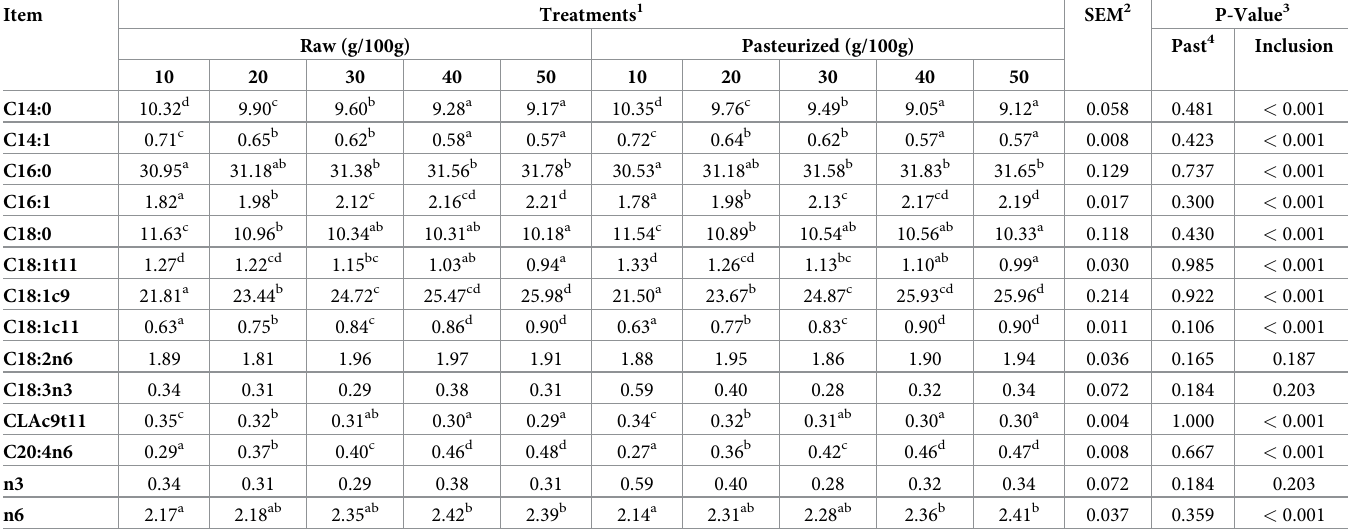
Table 3. Fatty acid profile of pasteurized and unpasteurized